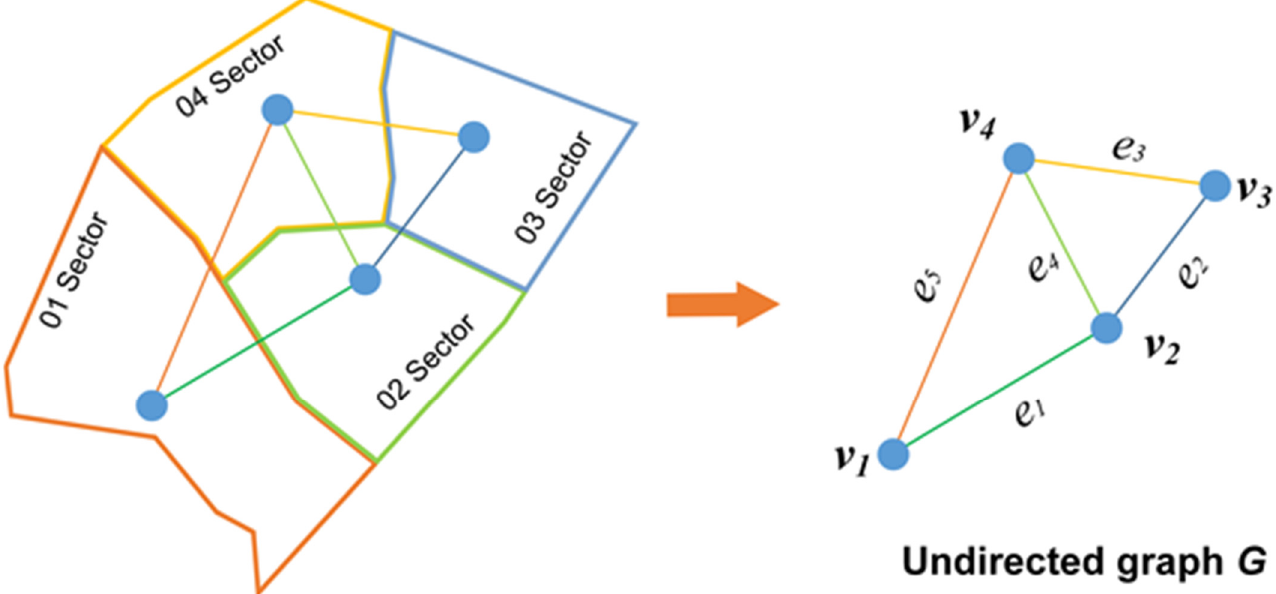
Figure 3. Abstraction to undirected graph based on sector adjacency. Representation of multiple sectors as undirected graphs based on the route connection relationship between sectors.